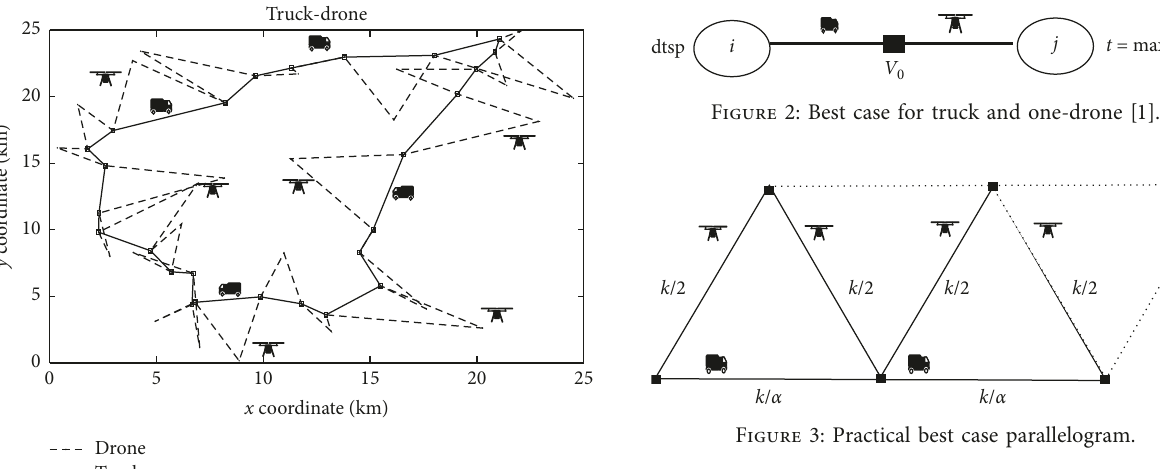
Figure 1: Truck with single-drone parcel delivery.